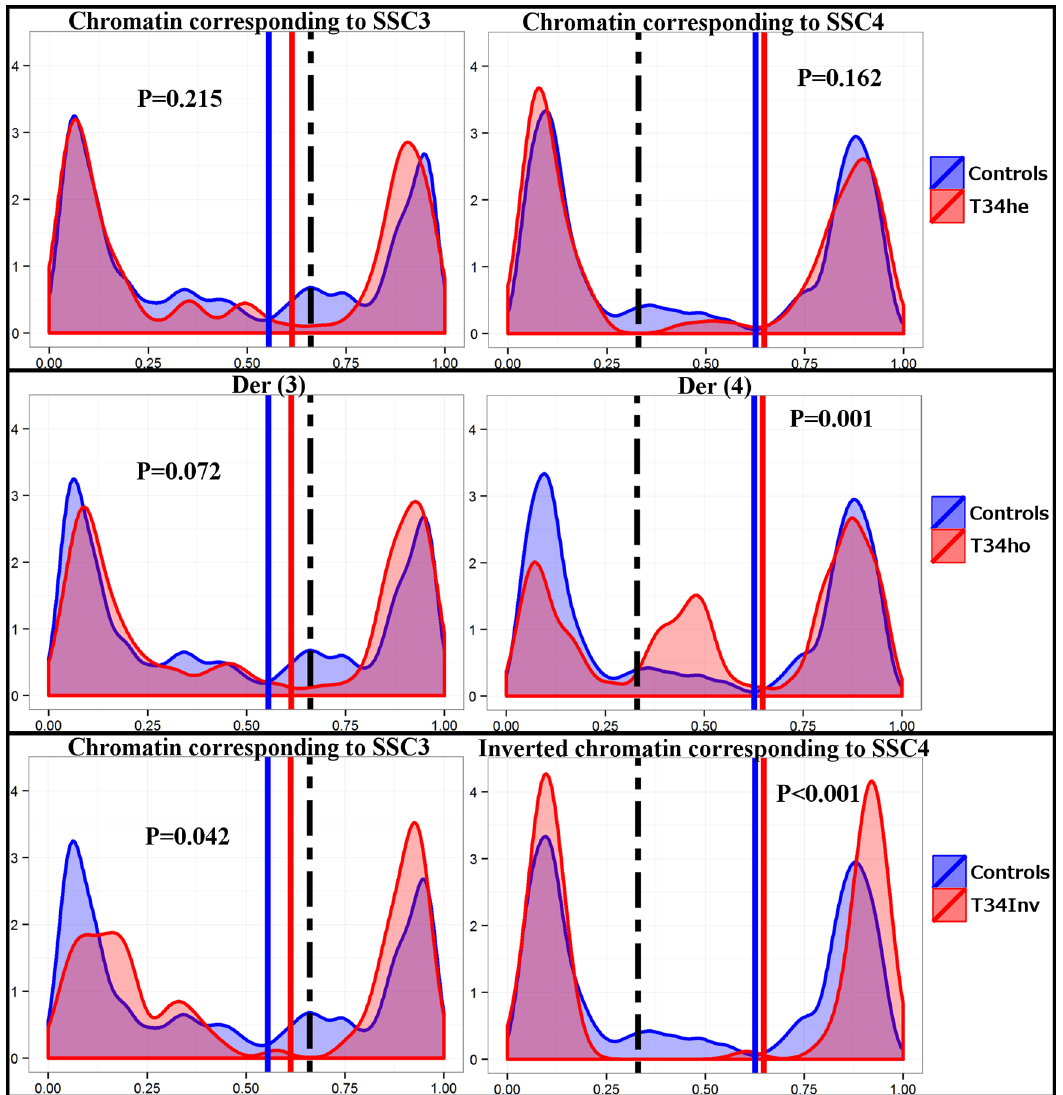
Fig 2. Comparison of the MLH1 distributions between rearranged chromosomes and controls. The y-axis indicates the frequency of the MLH1 signals along the SCs on the controls (in blue) and on the rearranged chromosomes (in red). The x-axis represents the length of the SCs in percent from the q (left) arm to the p (right) arm. The vertical lines in bold represent the centromeres and the dotted line represents the estimated position of the breakpoints on the translocated